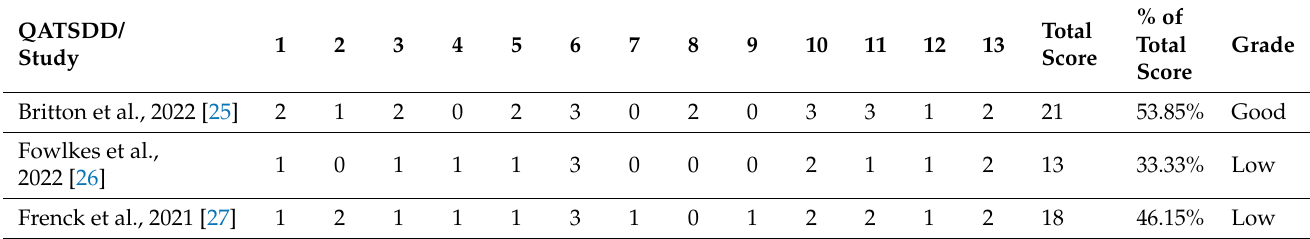
Table 3. Quality assessment of the studies using the Quality Assessment Tool for Studies with Diverse Designs (